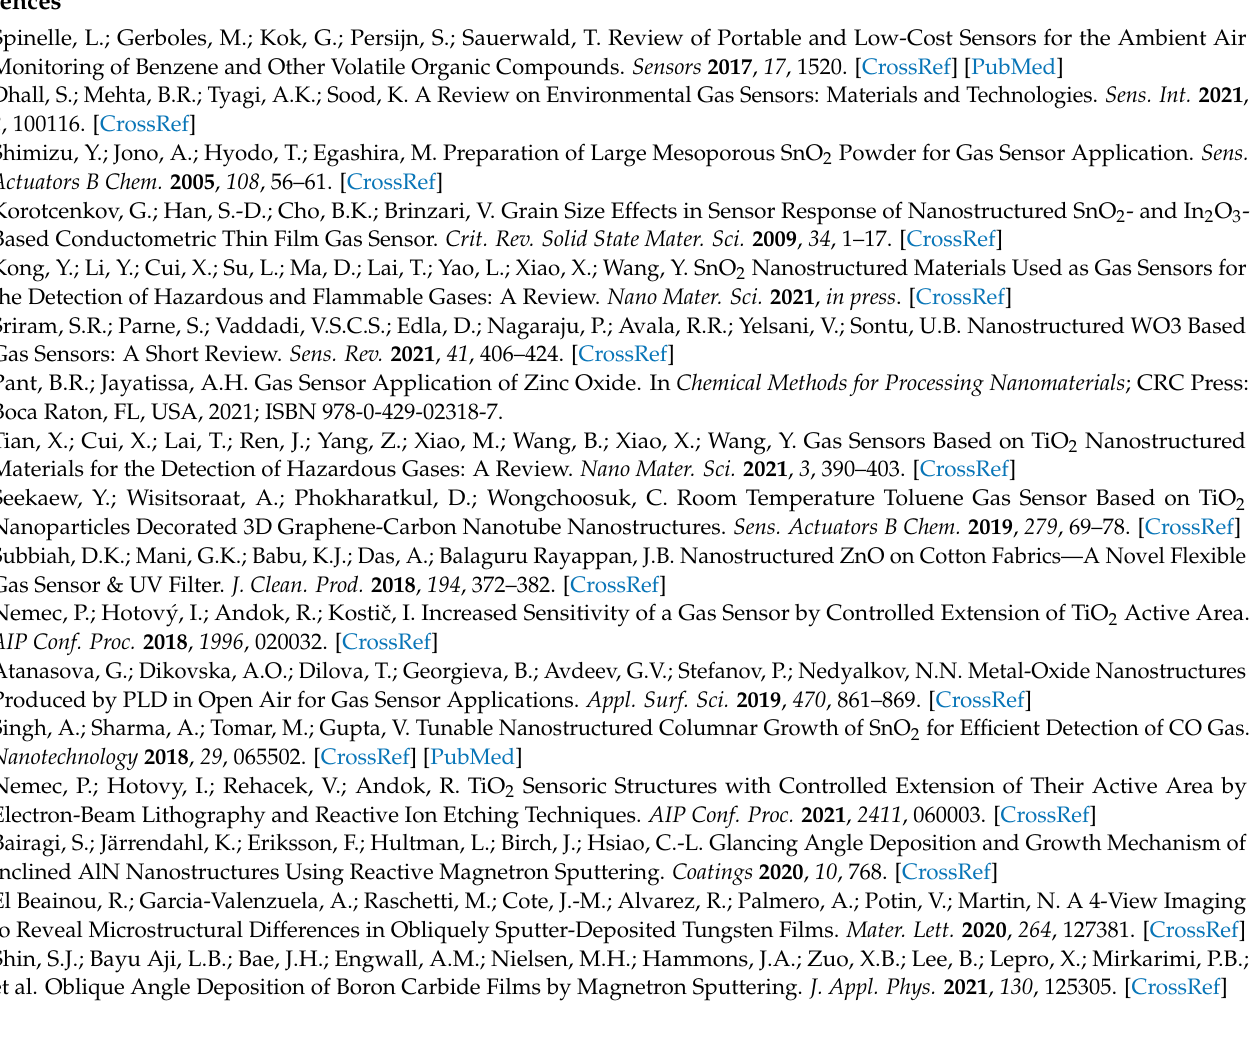
Figure S4: Dynamic normalized response of the SnO 2 -based gas sensors (C3, C6, I3, and I6) for different concentrations of (a) toluene, (b) ethylbenzene, (c) p-xylene, and (d) o-xylene. For all tests, 2 min. exposition time, 15 min. recovery time, and 100 mL min − 1 flow rate were